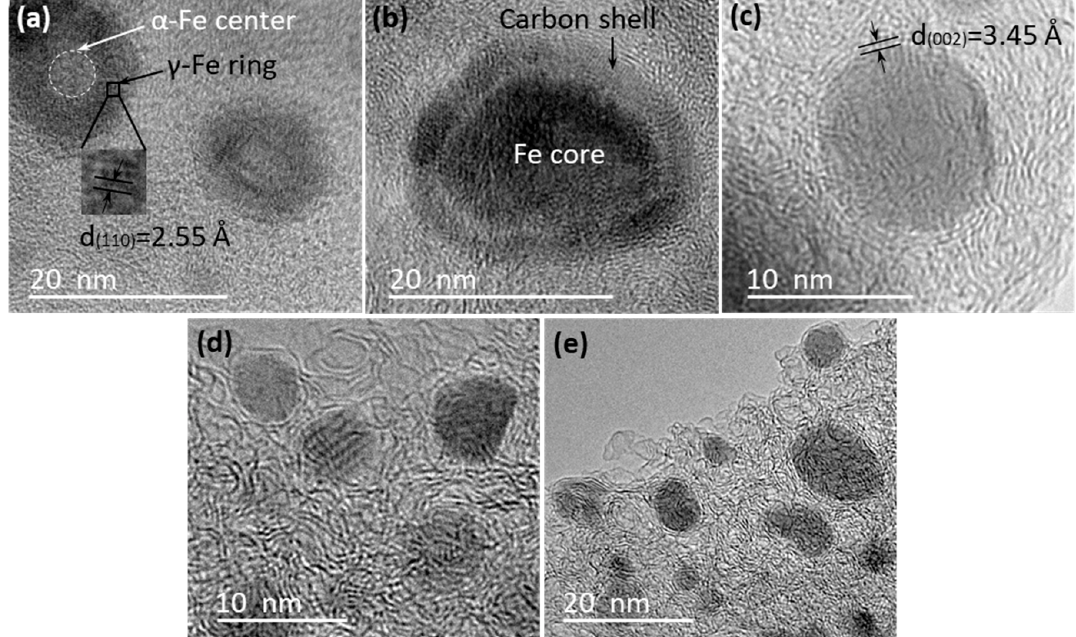
Figure 3. High-magnification TEM images of the iron nanoparticles embedded in the AC matrix in KL/Fe-700 ( a ), -750 ( b ), -800 ( c ), -900 ( d ), and -1000 ( e ) samples.